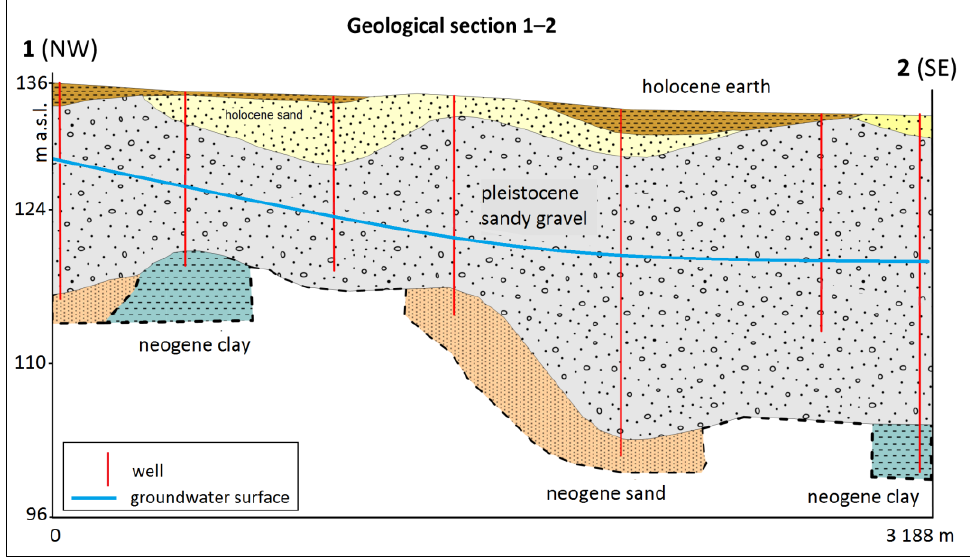
Figure 3. Geological section of modeled area central part (the refinery area) with approximate groundwater surface after [27], the section line depicted in Figure 4.